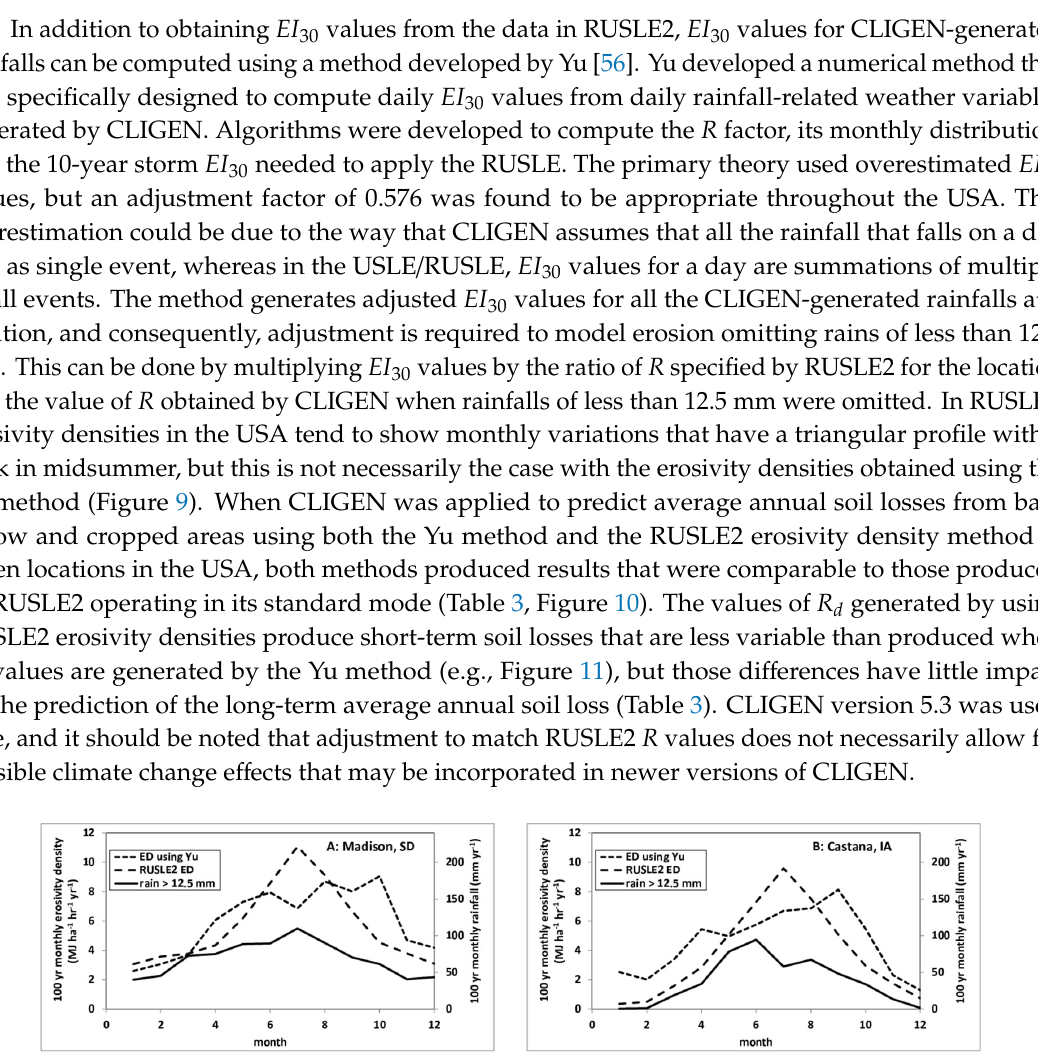
Figure 10. Average annual soil losses from bare fallow and cropped areas predicted by RUSLE2 when using CLIGEN for 100 years at seven locations in the USA ( A ) when using R d values generated by the Yu method, and ( B ) when using R d values based on RUSLE2 erosivity densities (source: Kinnell and Yu (under review) [57]).